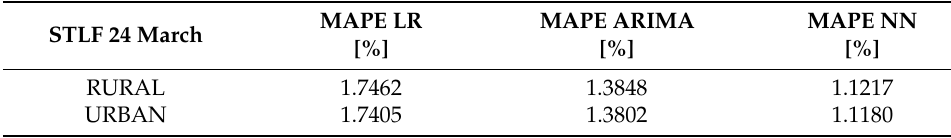
Table 2. MAPE results using the adapted STLF algorithm (TRIGGER